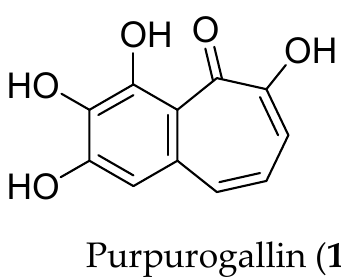
Figure 1. Structure of purpurogallin.